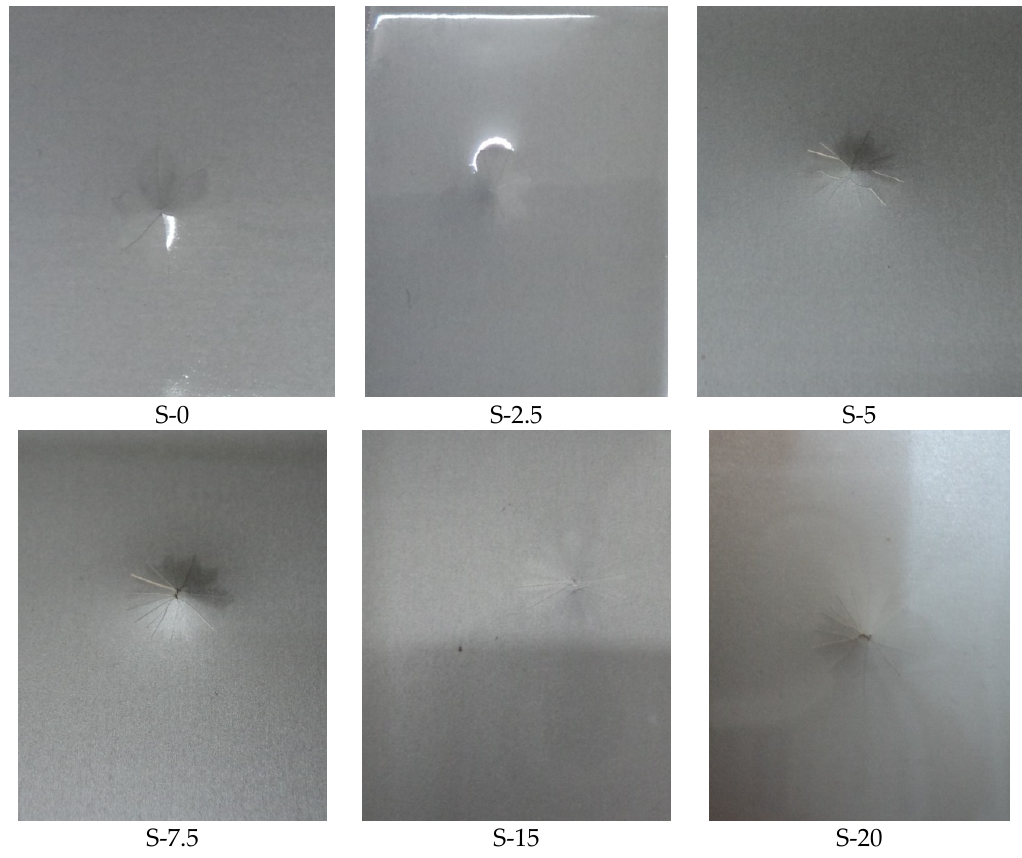
Figure 4. Picture of cracks that occurred on coatings after tubular impact test.